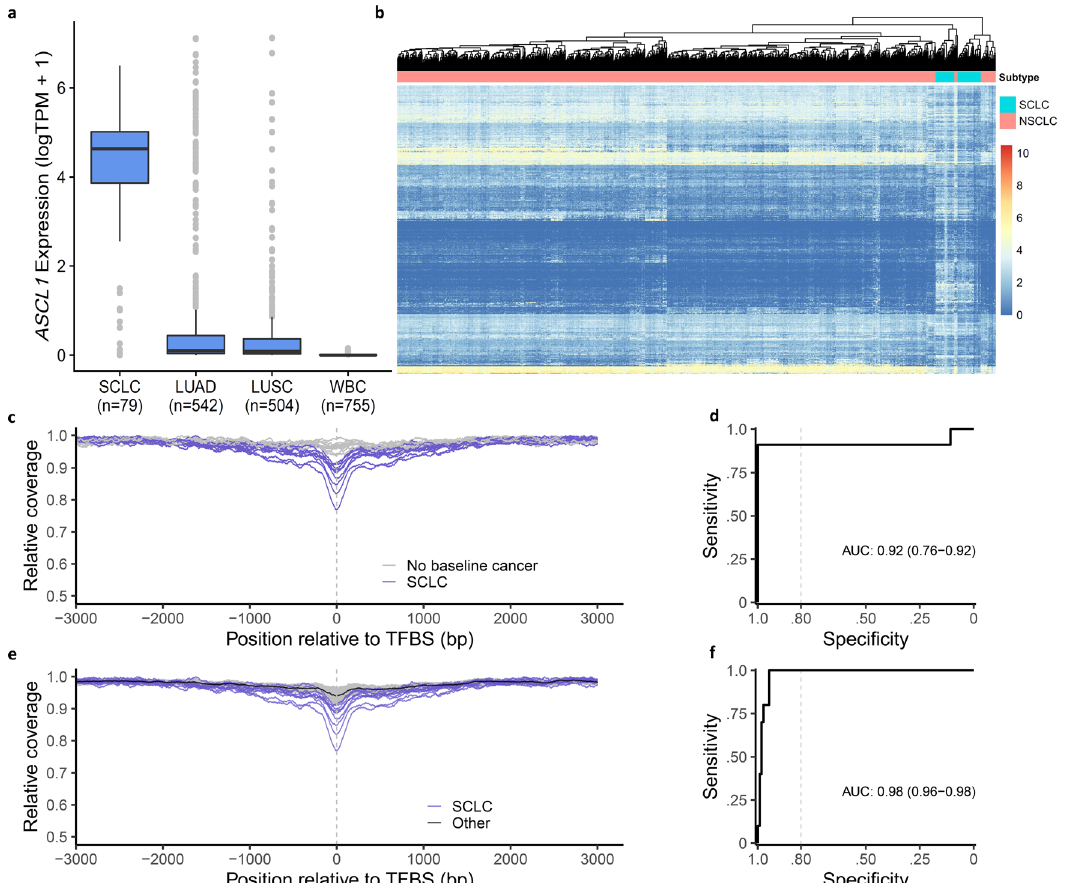
Fig. 5 Genome-wide fragmentation pro fi les can distinguish SCLC from NSCLC. a Expression of ASCL1 transcription factor in TCGA RNA-seq analyses of SCLCs ( n = 79) is high compared to NSCLC ( n = 1046) or WBC (755) samples. TPM transcripts per million. The center line in the boxplots represents the median, the upper limit of the boxplots represents the third quantile (75th percentile), the lower limit of the boxplots represents the fi rst quantile (25th percentile), the upper whiskers is the maximum value of the data that is within 1.5 times the interquartile range over the 75th percentile, and the lower whisker is the minimum value of the data that is within 1.5 times the interquartile range under the 25th percentile. b Unsupervised clustering analyses of gene expression in TCGA lung cancer cohorts show that genes with ASCL1 binding sites are differentially expressed between SCLCs and NSCLCs. Genome-wide cfDNA fragmentation analyses at ASCL1 binding sites in LUCAS cohort patients reveal a decrease in coverage near transcription factor binding sites of SCLC patients compared to non-cancer individuals ( c ) or DELFI positive patients with SCLC compared to other individuals ( e ). These molecular features can distinguish SCLC patients ( n = 11) from non-cancer individuals ( n = 158) ( d , AUC = 0.92) and DELFI positive SCLC patients ( n = 10) from NSCLC patients and others ( n = 115) ( f , AUC = 0.98), with high